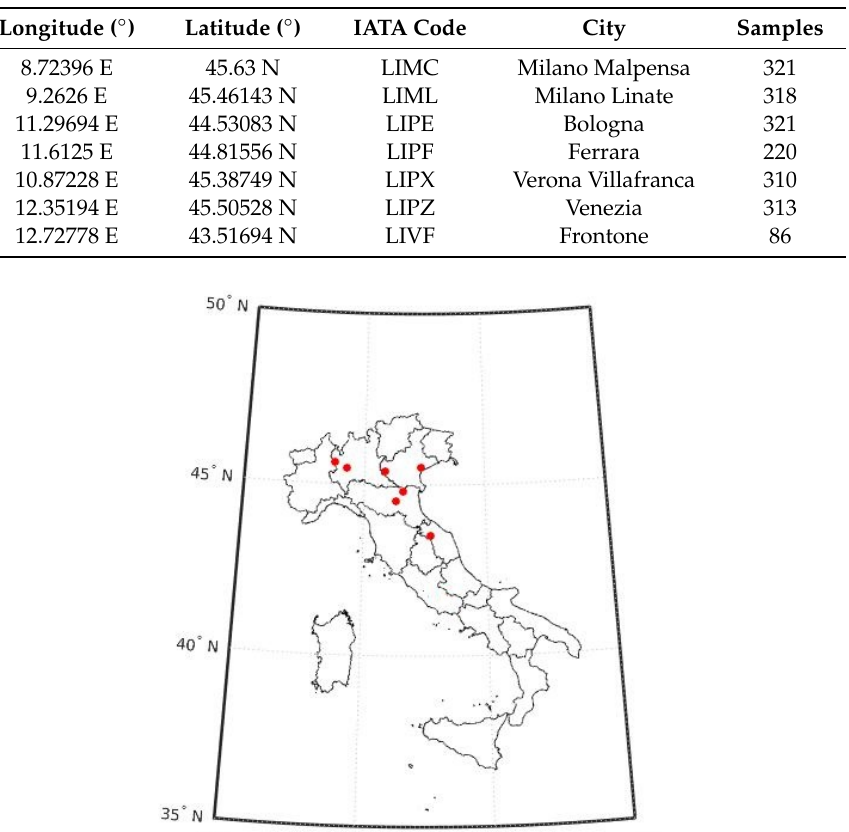
Table 1. List of sites used for WRF outputs performance evaluation and relative number of samples used for validation.